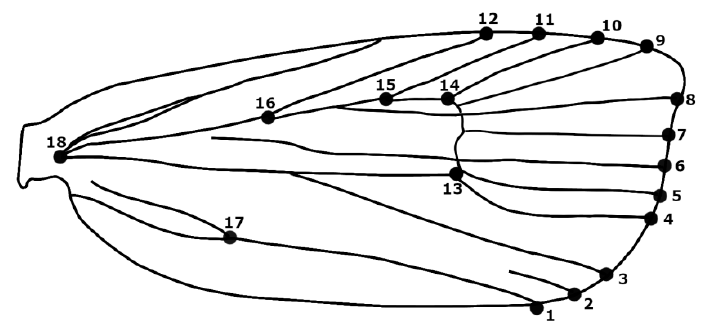
Figure 2. Position of 18 type 1 landmarks on a codling moth forewing.